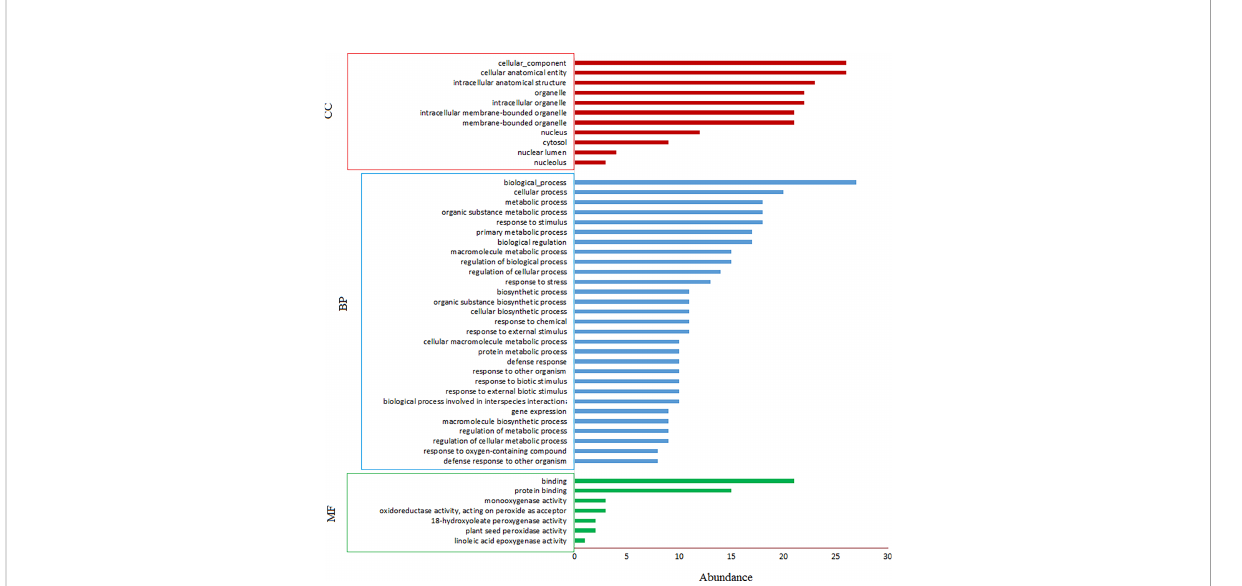
FIGURE 5 GO enrichment of saf fl ower cDNAs containing trinucleotide SSR motifs by gPro fi ler. MF, molecular function; BP, biological process; CC, cellular component; KEGG, KEGG, Kyoto Encyclopedia of Genes and